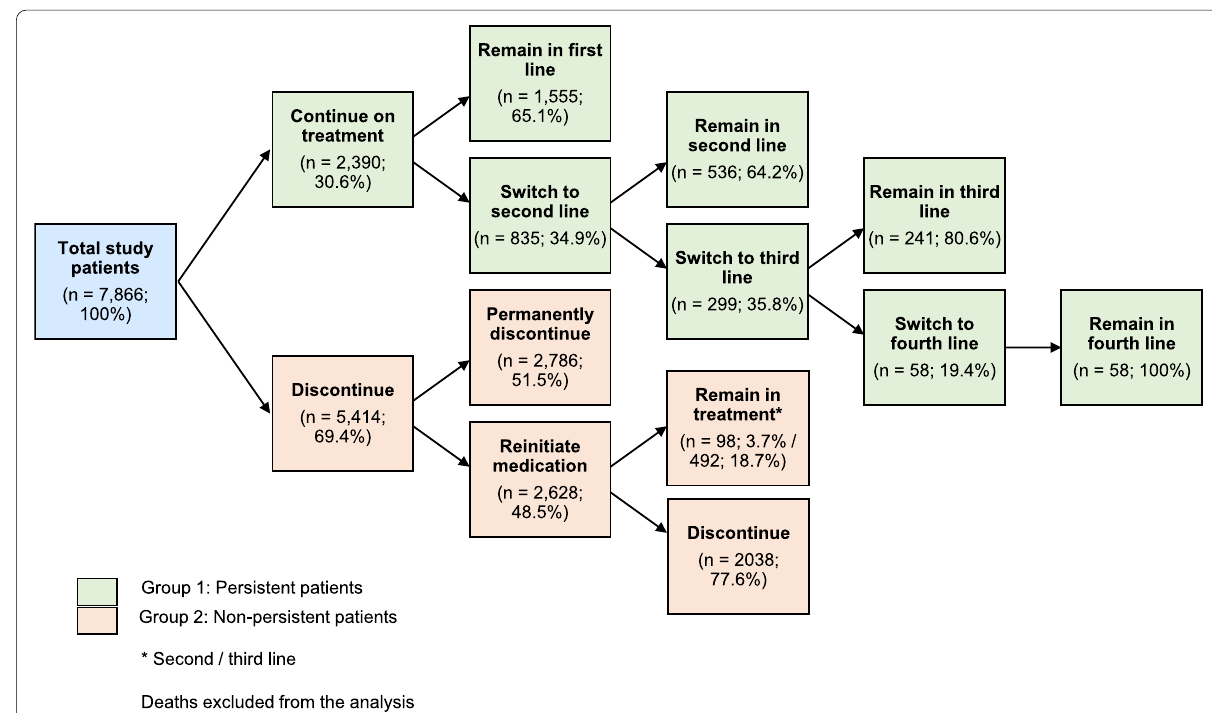
Fig. 3 Flow diagram of treatment evolution in the two study groups. Persistent patients continued on their migraine preventive medication during the 12‑month follow‑up period or switched to another line of treatment within 60 days from the last prescription. Non‑persistent patients permanently discontinued their preventive treatment or restarted it after 60